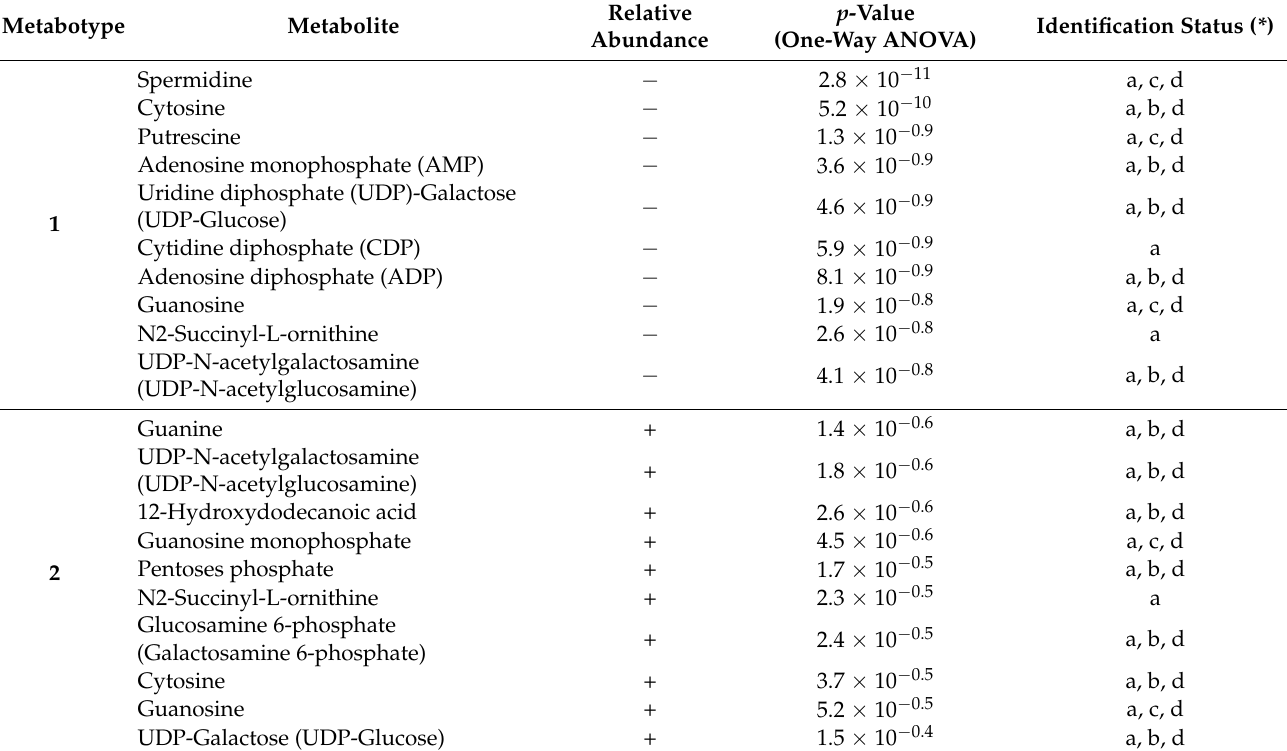
Table 1. Listof the10Metabolites MostStronglyAssociatedwith theThreeMetabotypesObserved Amongthe P.a ClinicalIsolates.